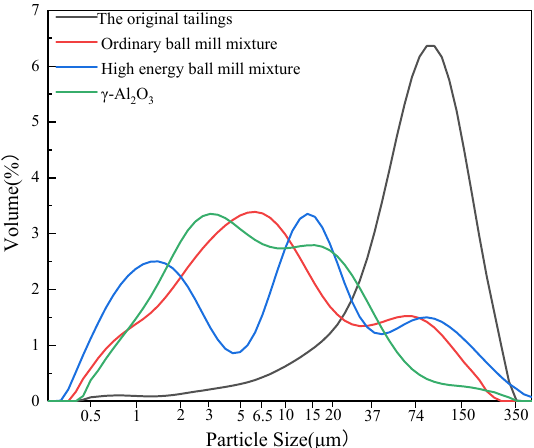
Figure 3. Particle size analysis of minerals.